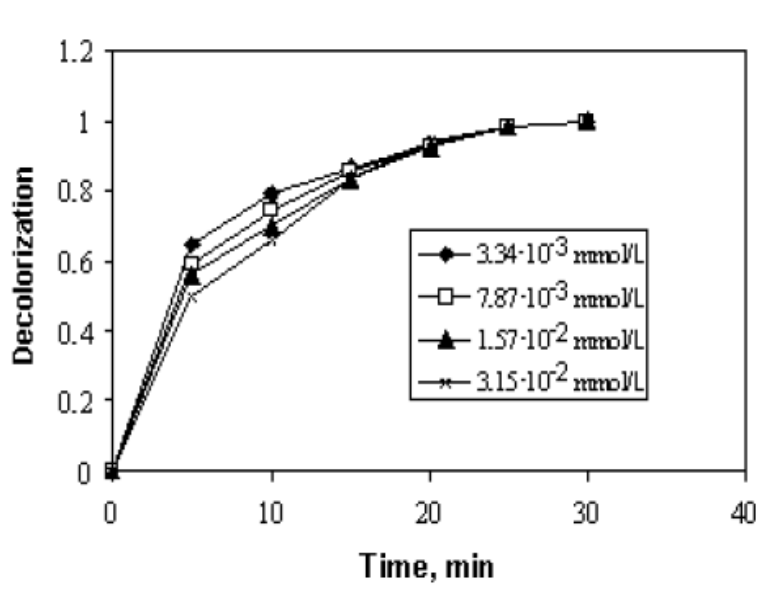
Fig. 11 Effect of Cu 2+ ions on AOP in neutral medium. Initial conditions: C dye =50 mg/L, [H 2 O 2 ]= 17.318 mM.